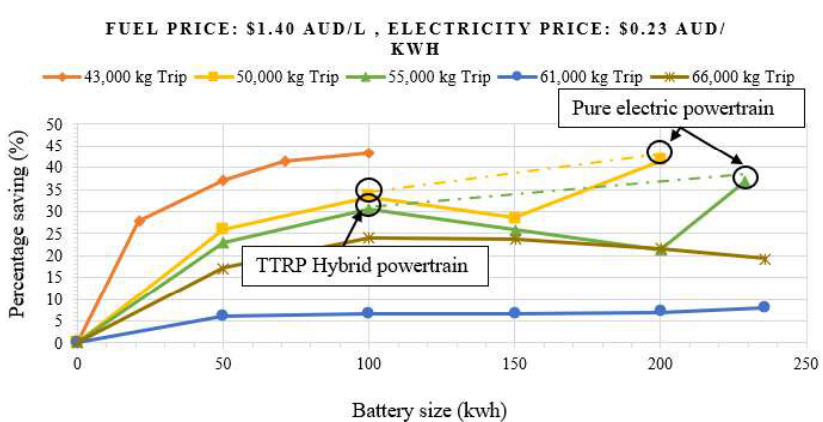
Figure 16. Strategy for electric power train selected for continuous upwards trend of operational cost savings.